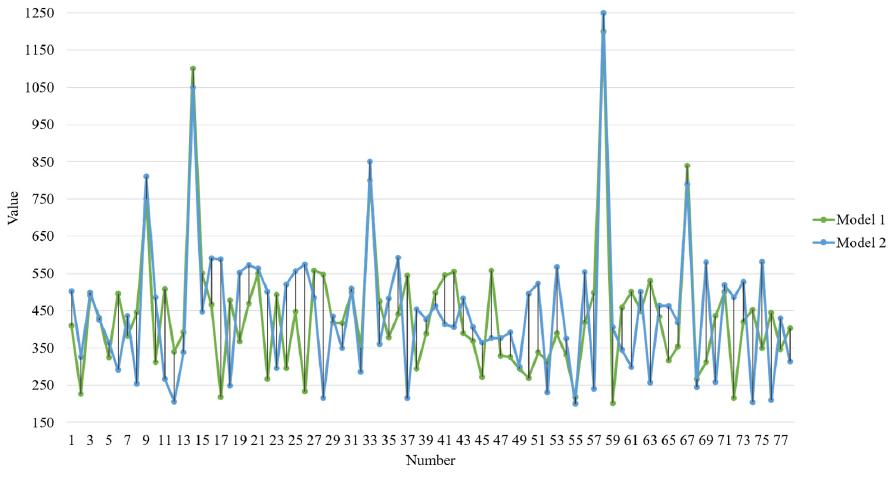
Figure 6. Response time distribution